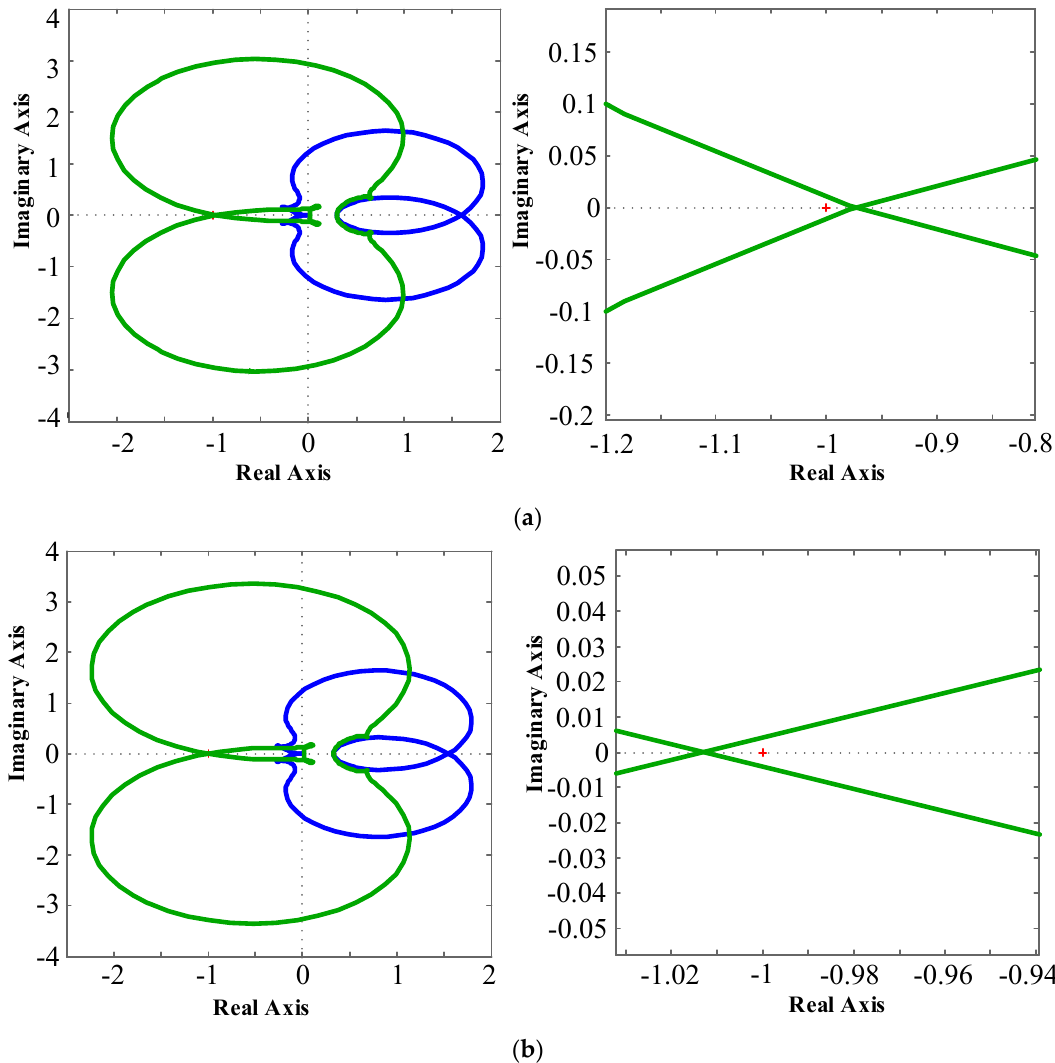
Figure 17. The Nyquist plots of the feedback loop gain: ( a ) Nyquist plots in the stable case ( k igP = 1), the graphs on the right are the magnified parts in ( − 1, j0). The point ( − 1, j0) is not enclosed by the curve, and the system is still stable; ( b ) Nyquist plots in the unstable case ( k igP = 0.9), the graphs on the right are the magnified parts in ( − 1, j0). The curves enclose ( − 1, j0) and the system becomes unstable. Table 4. Controller parameter 1 influences and assessments on the system’s stability.